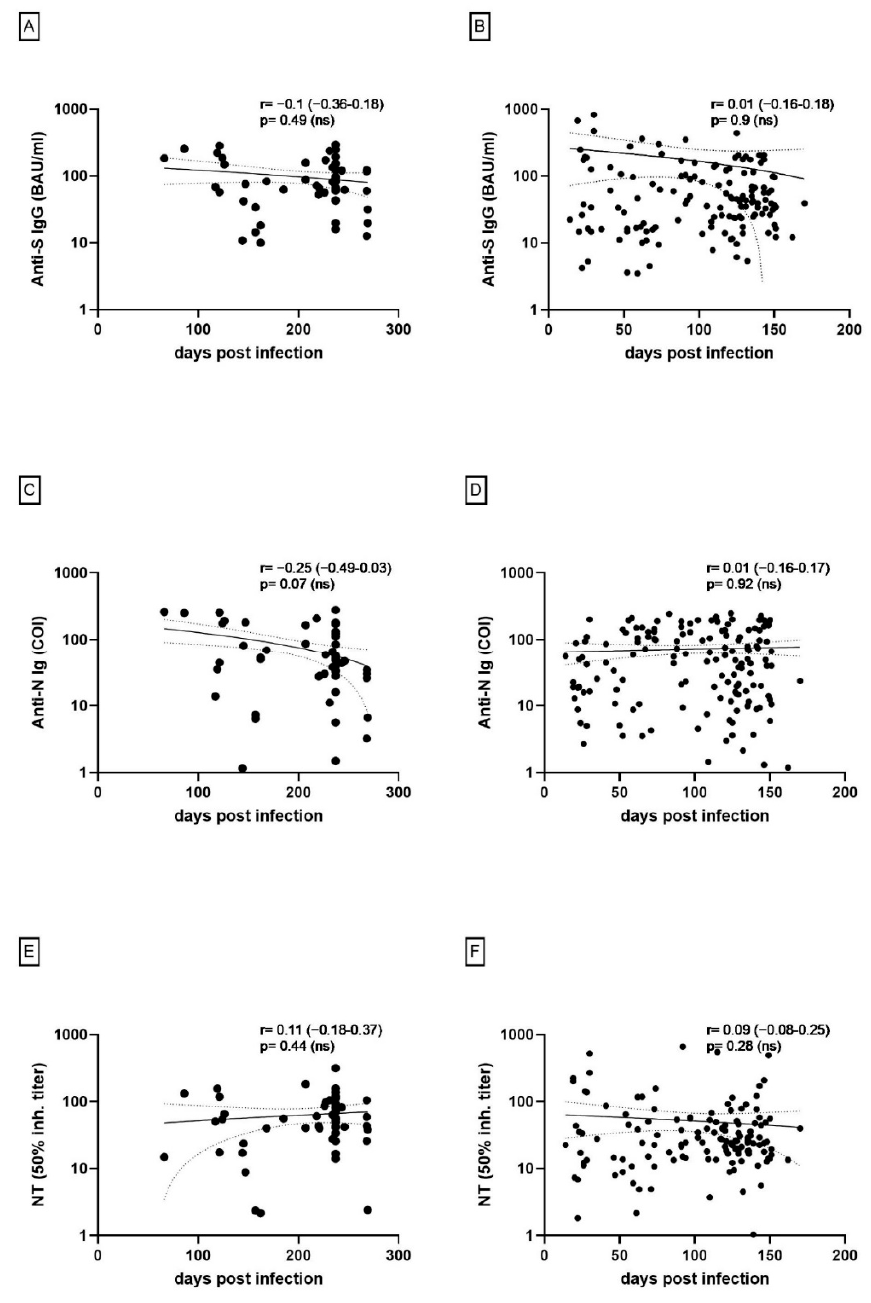
Figure 1. Characterizing the level of anti-SARS-CoV-2 anti-S and anti-N antibody concentration across the number of days post-infection using spearman’s correlation method: ( A , B ) Anti-S antibodies across time in children ( A ) and adults ( B ); ( C , D ) Anti-N antibodies across time in children ( C ) and adults ( D ); ( E , F ) Neutralizing antibody titers across time in children ( E ) and adults ( F